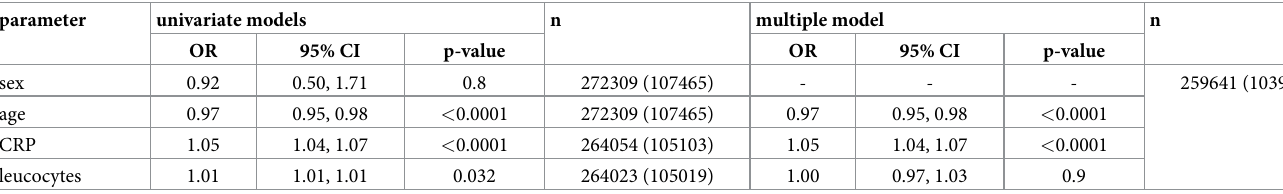
Table 2. Epidemiologic factors associated with TB diagnosis in patients with hyponatremia. Young age and high CRP parameters conferred a higher TB diagnosis risk in patients with hyponatremia in a multiple logistic regression model for correlated data. TB, tuberculosis. OR, odds ratio. CRP, C-reactive protein. n, number of